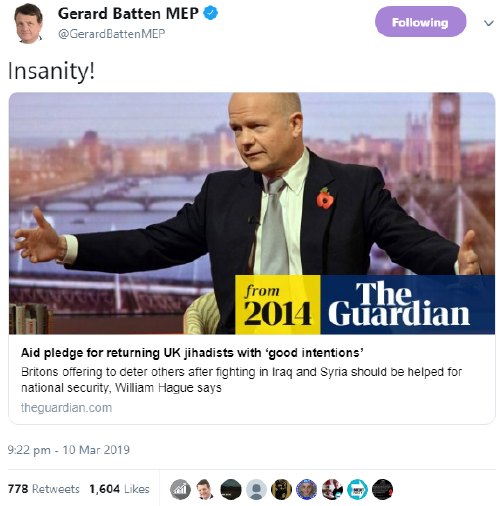
Figure 7. Tweet from UKIP leader Gerard Batten, 10 March 2019.